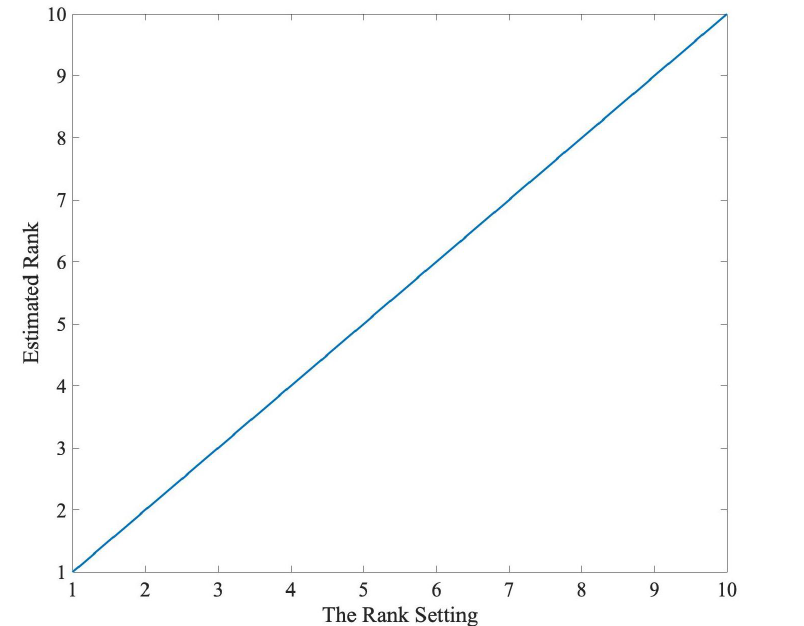
Figure 3. The rank setting vs. estimated rank of Algorithm 2.